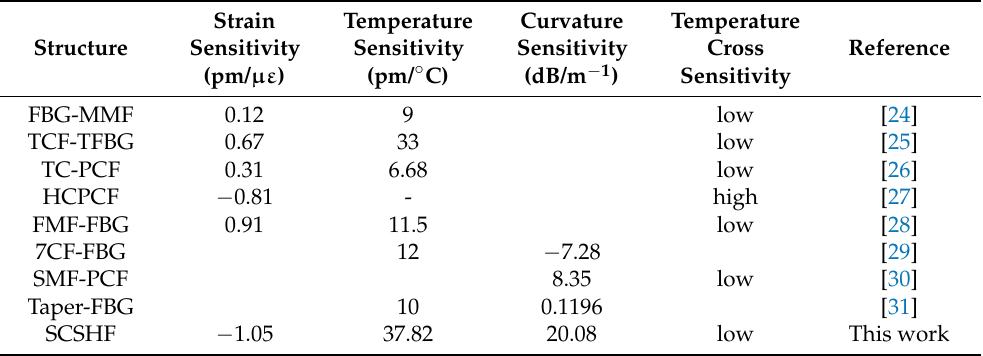
Table 3. Comparison with other optical fiber